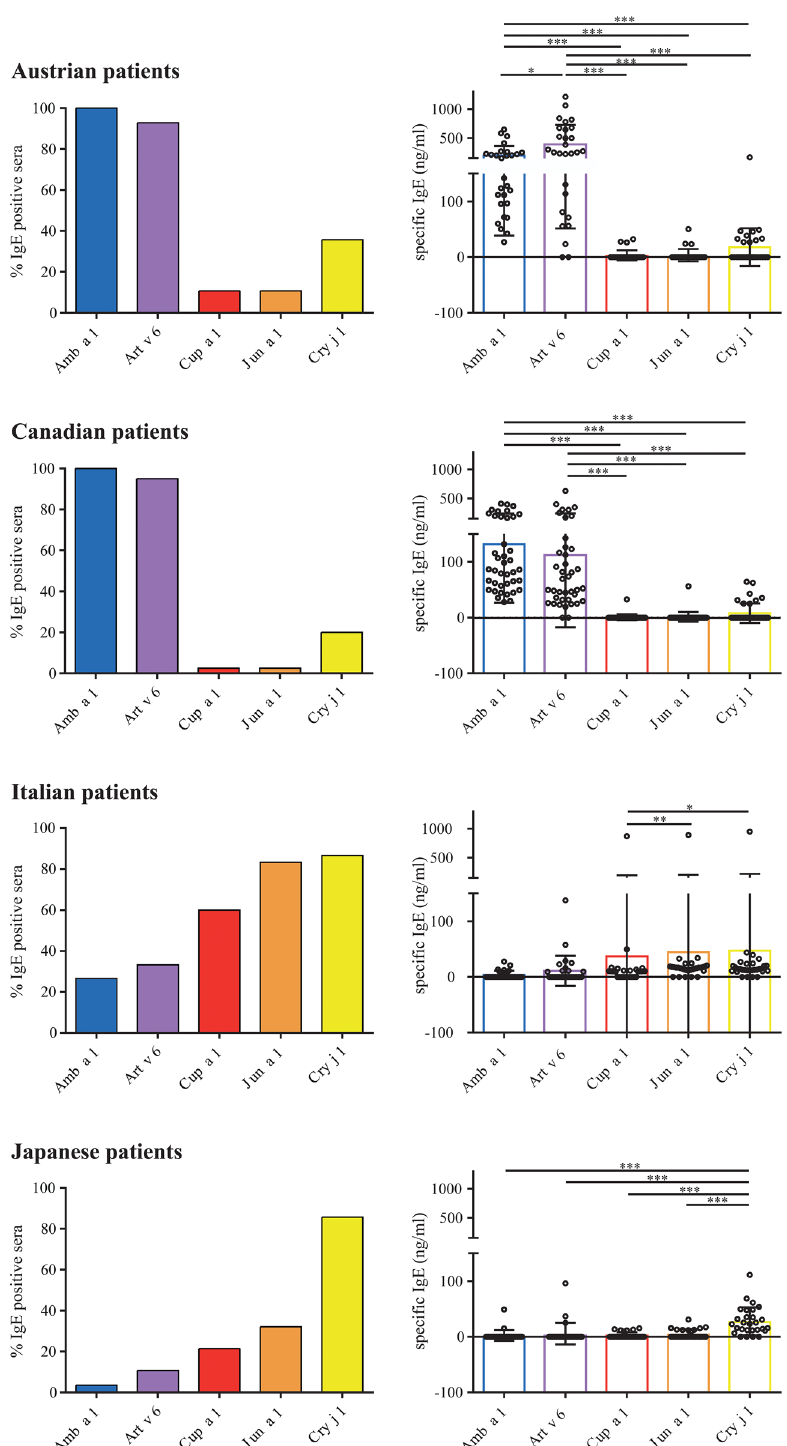
Fig 3. Patients´ serum IgE levels determined by ELISA. IgE binding of sera from Austrian (n = 28), Canadian (n = 40), Italian (n = 30), and Japanese (n = 28) Asteraceae and Cupressaceae pollen allergic patients were tested on natural Amb a 1, Art v 6, Cup a 1, Jun a 1, and Cry j 1. % values for IgE positive sera are given on the left, IgE levels are presented as mean ± SD on the right. Statistical analysis was performed with Repeated Measures ANOVA and Tukey´s Multiple Comparison Test ( * P < .05, ** P < .01, *** P <